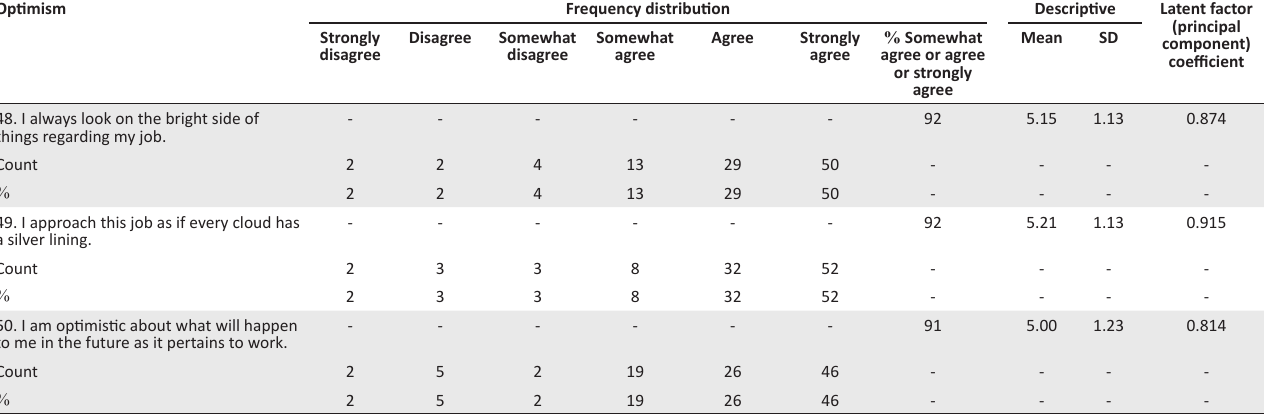
TABLE 14: Analysis of the construct of optimism. Optimism Frequency distribution